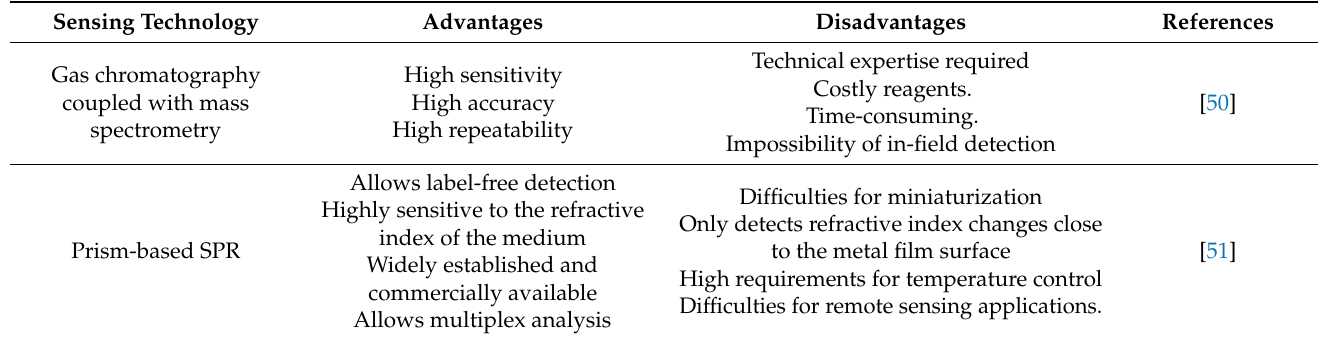
Table 5. Comparison of latest sensing technologies used in